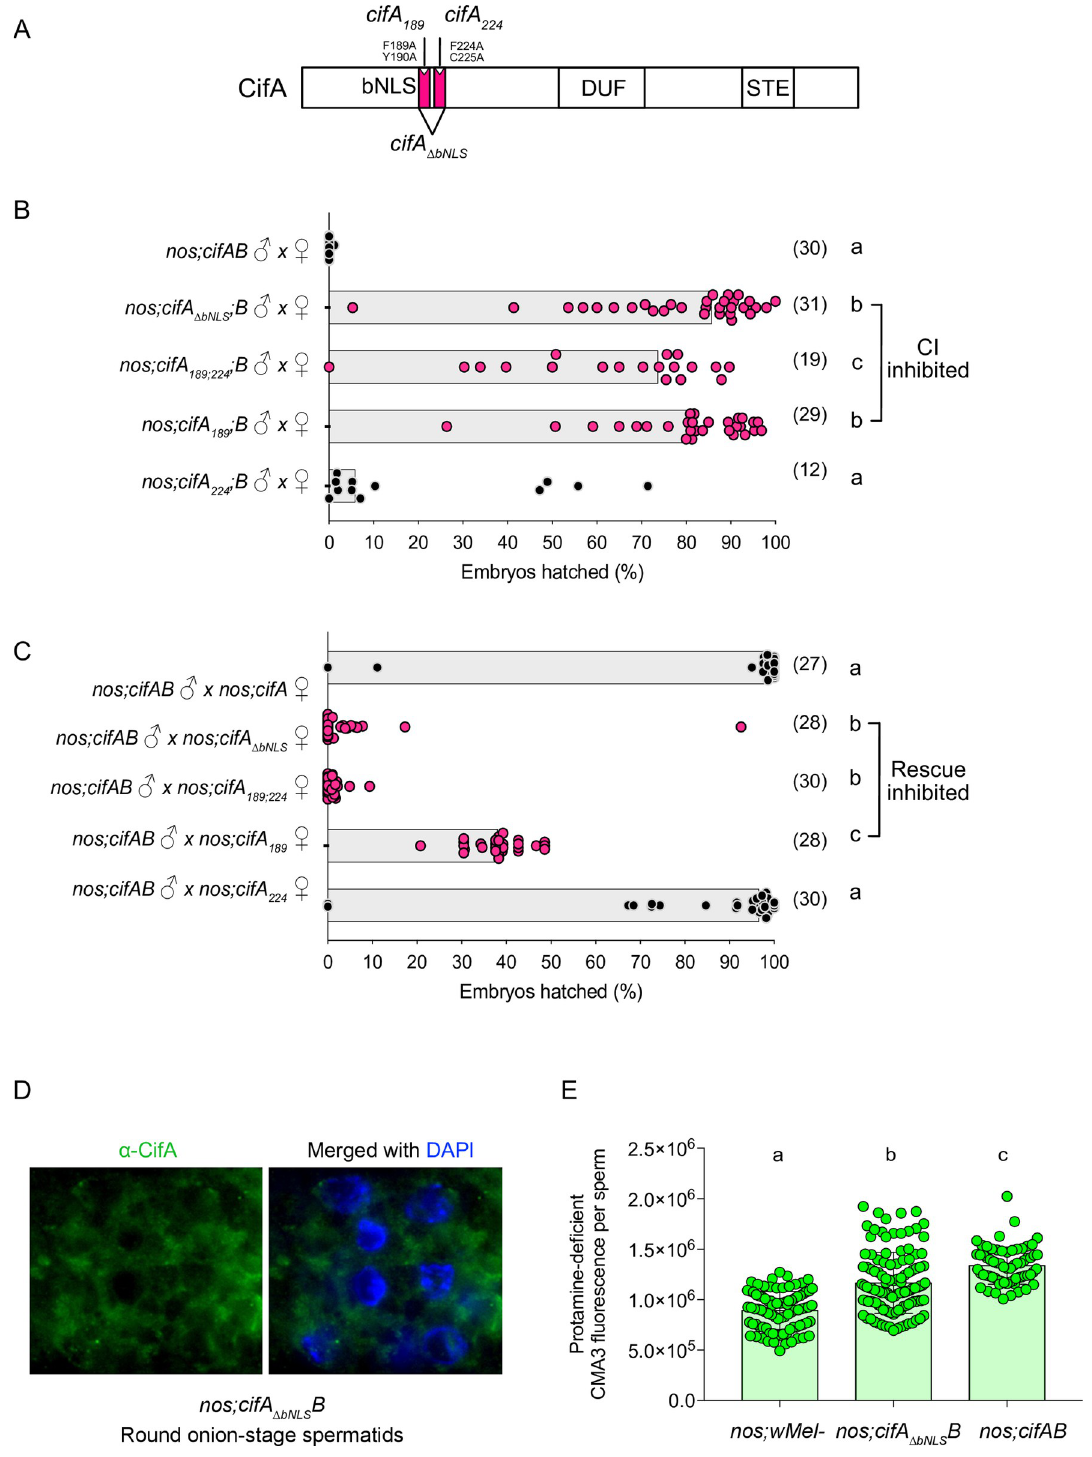
Fig 4. A nuclear localization signal in CifA is necessary for CI, rescue, and protamine levels. (A) Schematic representation of CifA annotation shows the annotated bNLS with engineered amino acid substitutions and deletions. (B, C) Hatch rate assays assessed both CI (B) and rescue (C) in flies expressing wild-type, transgenic, and mutant cifA . Each dot represents the percent of embryos that hatched from a single male and female pair. Sample size is listed in parentheses. Horizontal bars represent the median. Letters to the right indicate significant differences determined by a Kruskal–Wallis test and Dunn multiple comparison tests. All the p -values